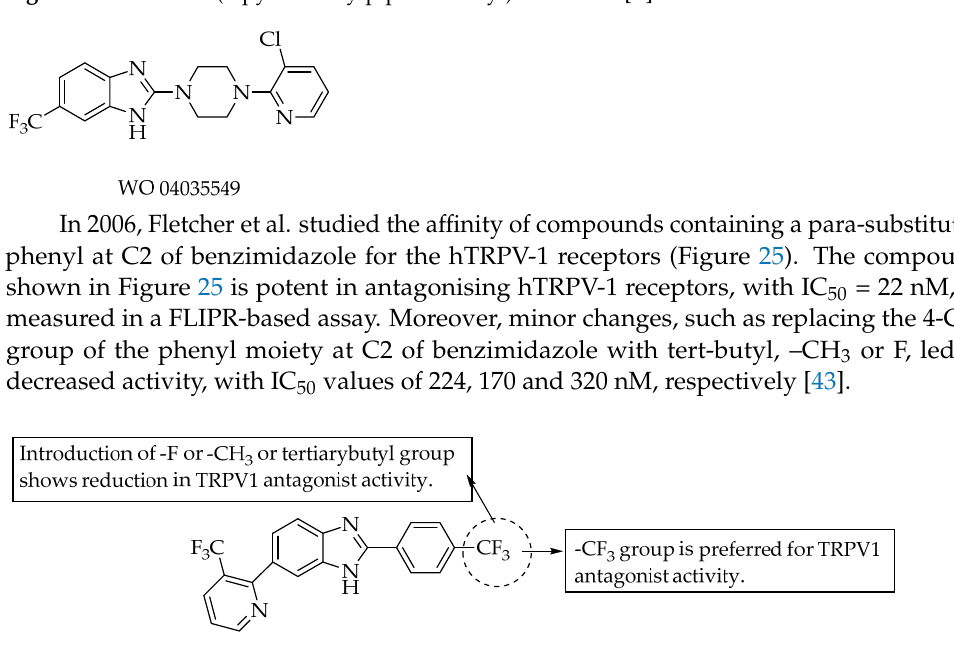
Figure 24 . SARs of 2-(4-pyridin-2--ylpiperazin-1-yl)-1 H -benzo-[d]imidazoles.